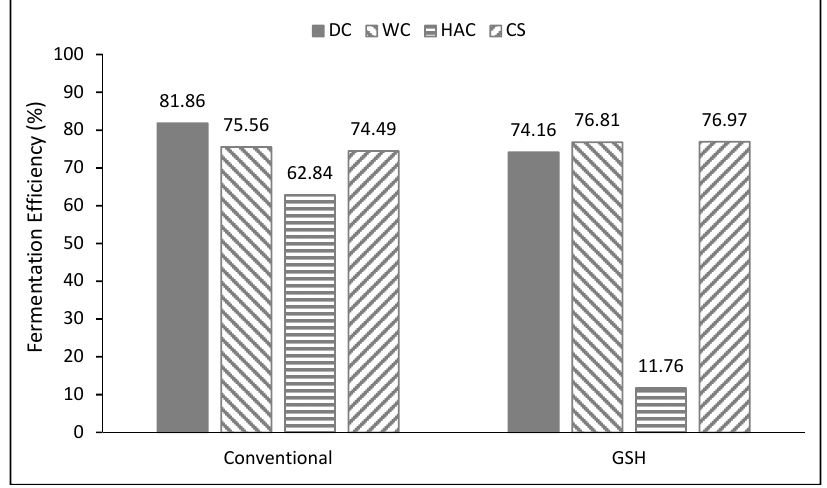
Figure 5. Fermentation efficiencies of four starches (dent corn (DC), waxy corn (WC), high amylase corn (HAC) and cassava starch (CS) with conventional and GSH method.